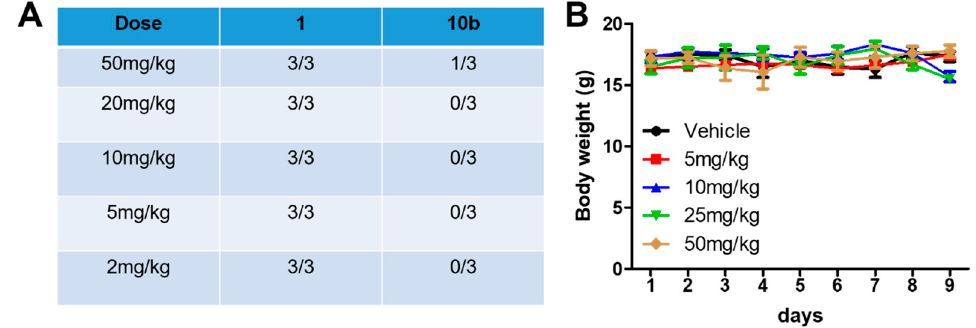
Figure 3. ( A ) The percentage of death in mice after the administration of cucurbitacin B and compound 10b . ( B ) The body weight change after the administration of compound 10b by intravenous injection.